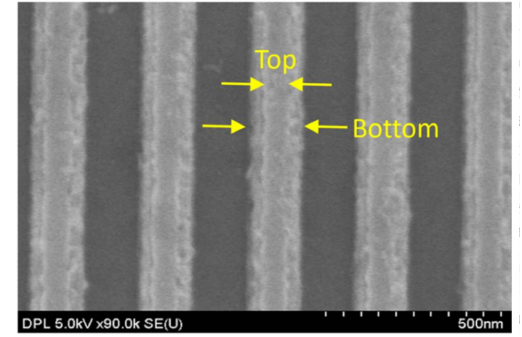
Figure 2. Scanning electron microscopy (SEM) micrograph of meta-grating sample. Note the trapezoidal